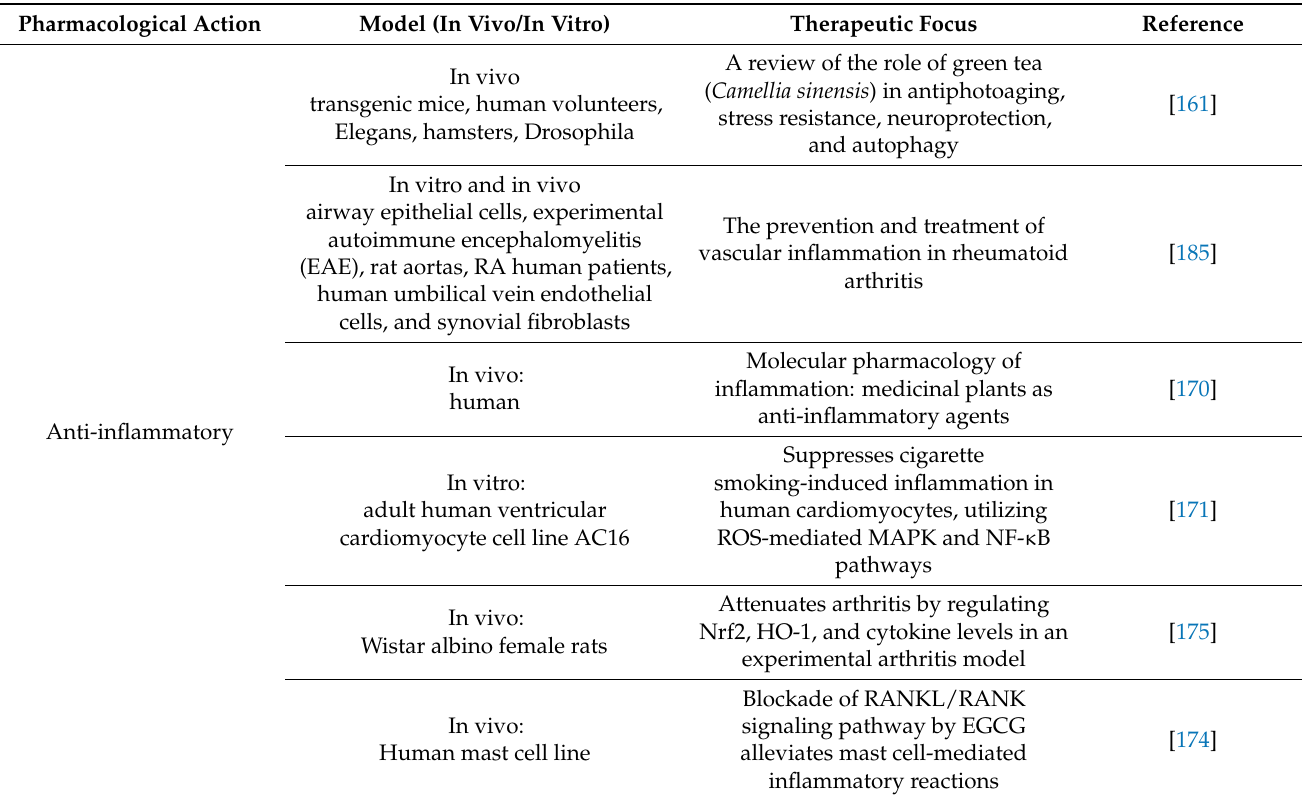
Table 1. Possible mechanisms of EGCG neuroprotective action in AD demonstrated in various disease